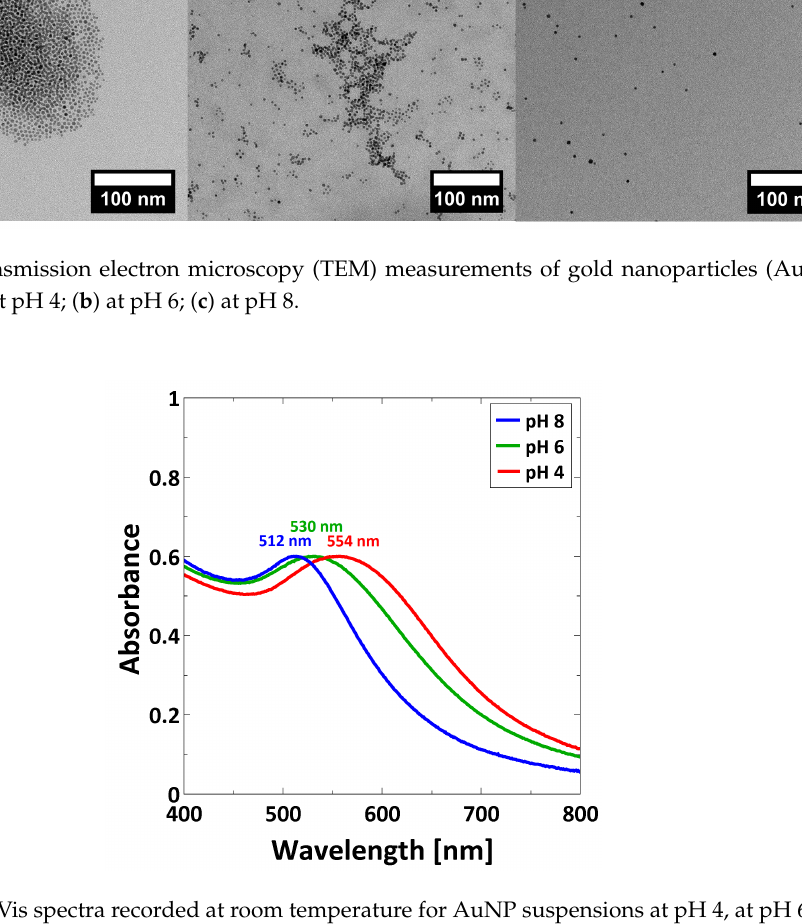
Figure 5. UV/Vis spectra recorded at room temperature for AuNP suspensions at pH 4, at pH 6 and at pH